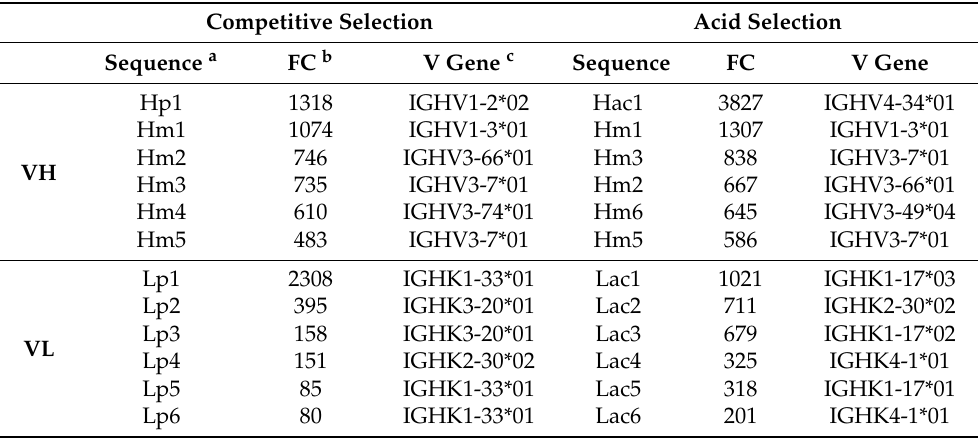
Table 1. Characterization of selected heavy chain variable domains (H) and light chain variable domains